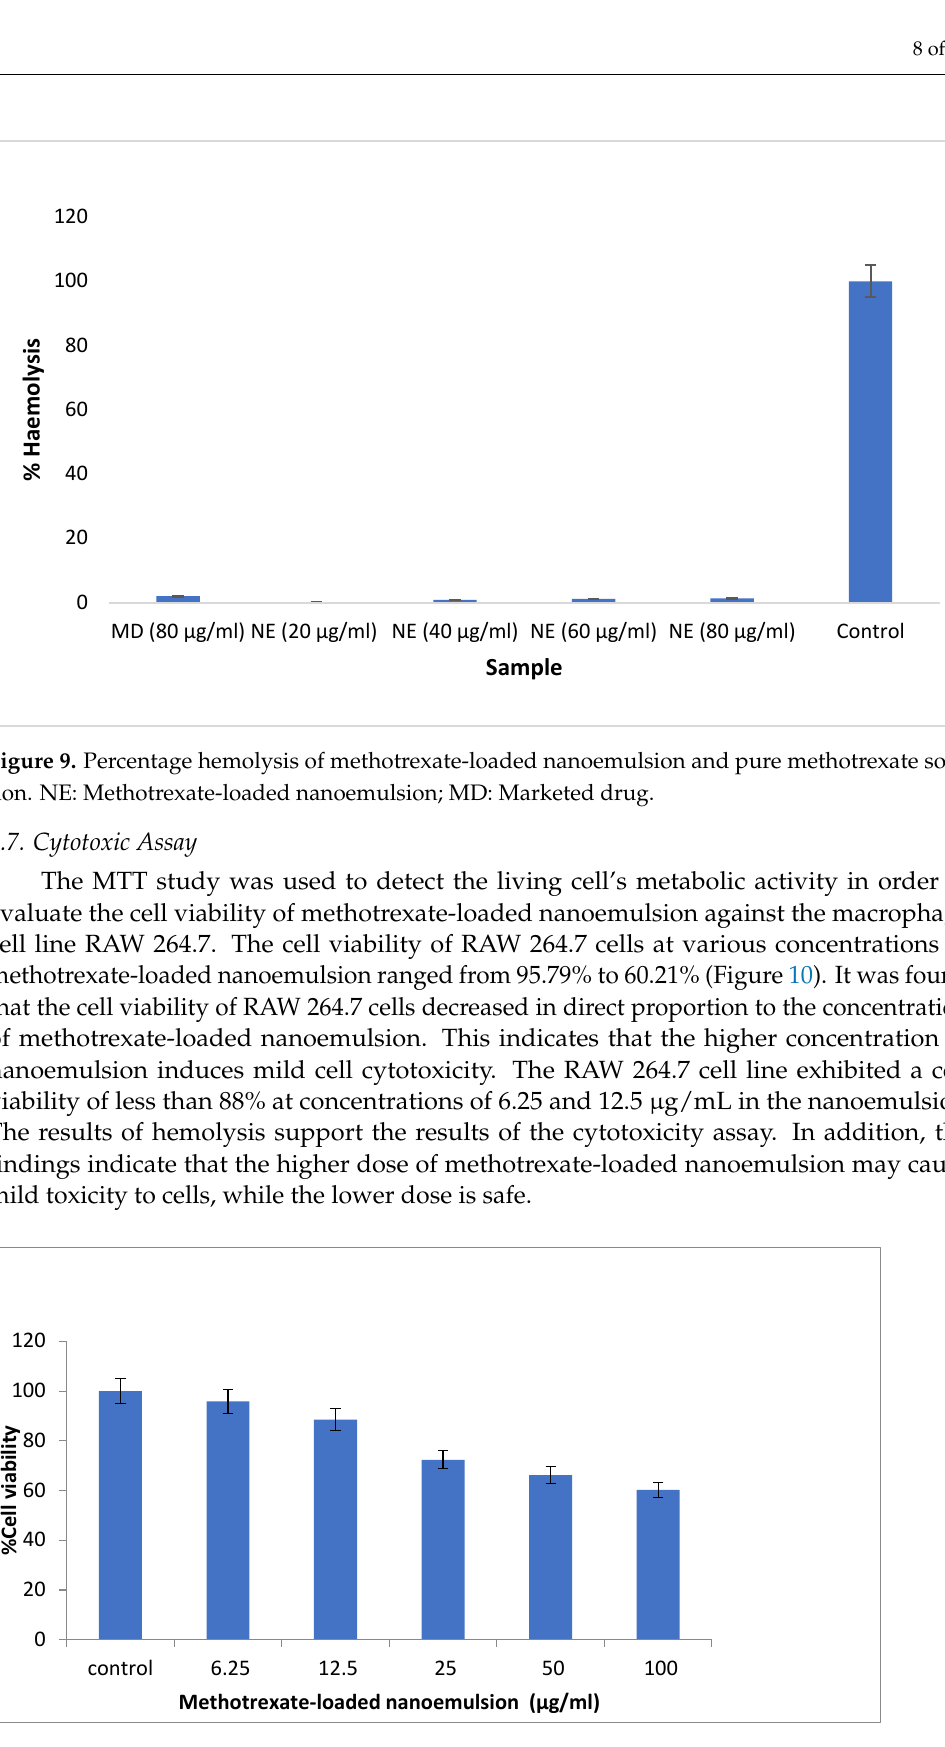
Figure 10. Graphical representation of in vitro cytotoxic effect of methotrexate-loaded nanoemul-